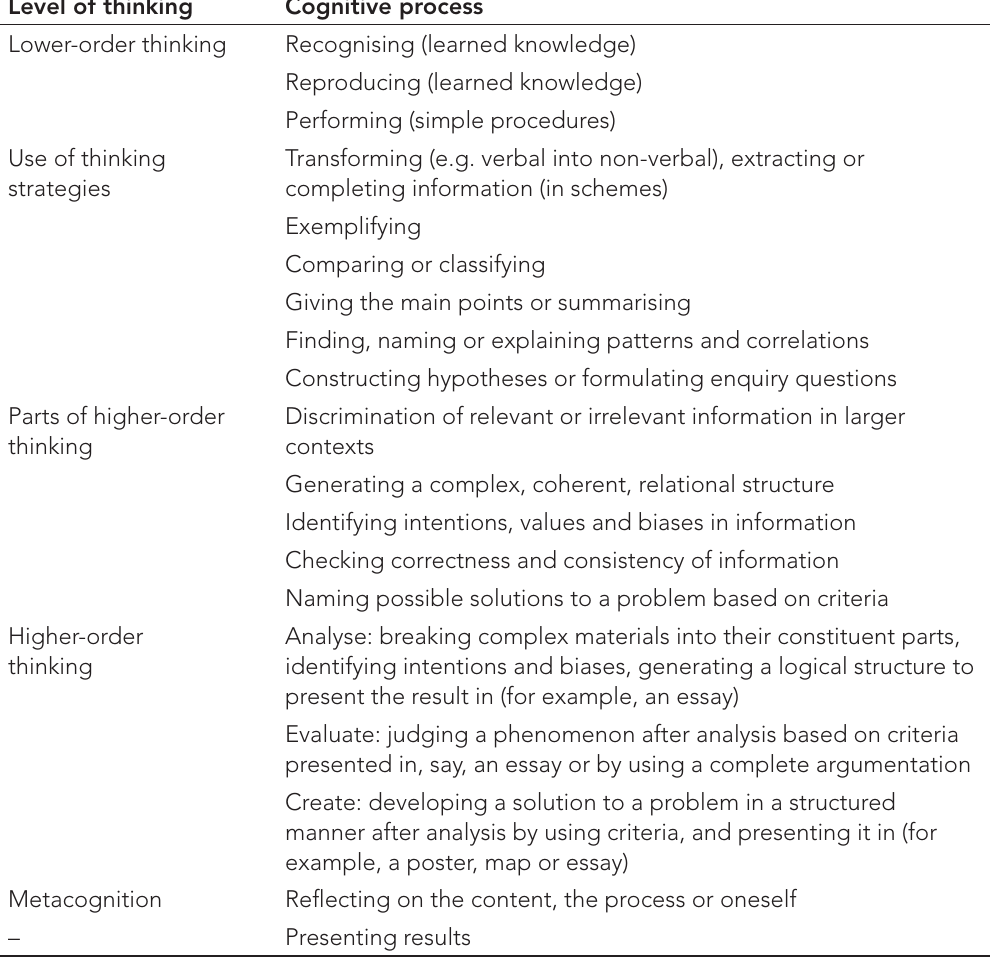
Table 1: Geography Task Classification Framework (Adapted from Krause et al.,